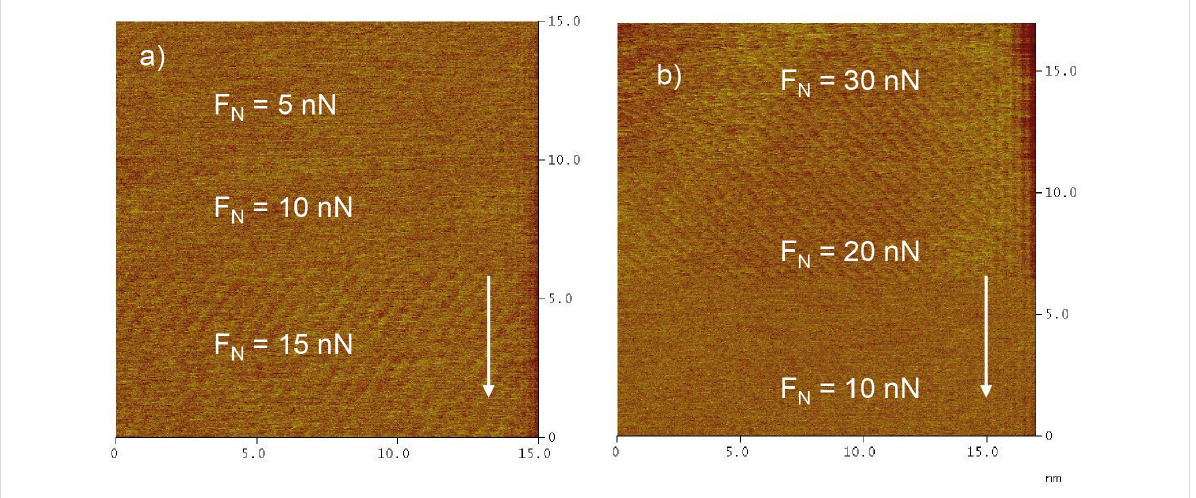
Figure 11: Transition between regular and irregular stick–slip on copper 2/3 during an increase ( а ) and a decrease (b) of normal load. E = 100 mV; scan rate 180 nm/s.